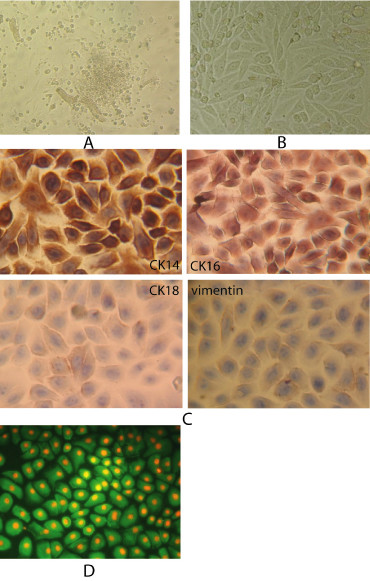
Primary cultures of ameloblastoma cells. (A) Primary culture ameloblastoma cells formed a colony or migrated out from ameloblastoma tissue under phase-contrast microscopy (× 100). (B) Sub-cultured ameloblastoma cells had vigorous growth in 2–4 passages. Cells were large and flattened or spindle-shaped under phase-contrast microscopy (× 200). (C) Immunocytochemistry confirmed the epithelial origin of the ameloblastoma cells based on cytokeratin 14 and 16 expression; cytokeratin 18 and vimentin were only weakly expressed (× 300). (D) Immunofluorescence for MMP-2 in ameloblastoma cells. Cells were examined and photographed under fluorescent microscopy. The green fluorescence shows the localization of MMP-2 and nuclei were counterstained with propidium iodine (PI) which fluoresced red (× 300).